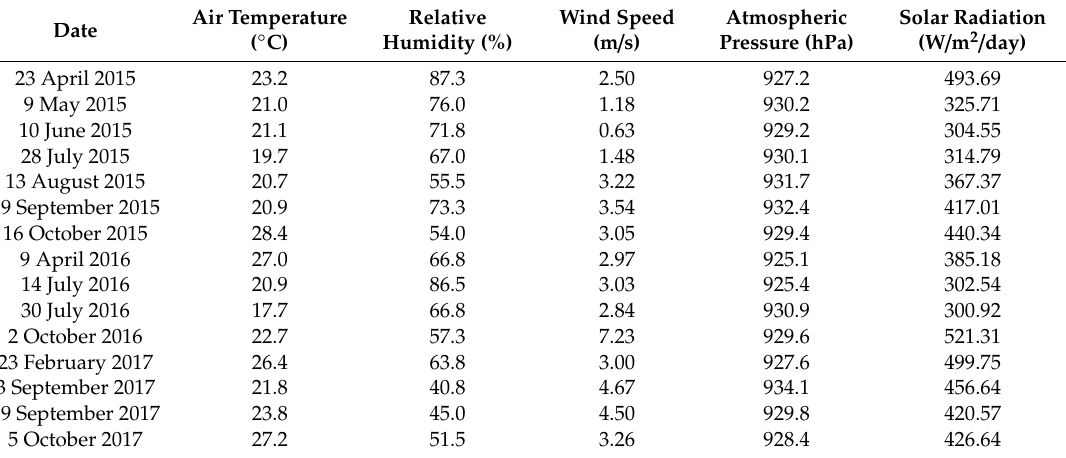
Table 2. Daily average weather conditions on the date of image